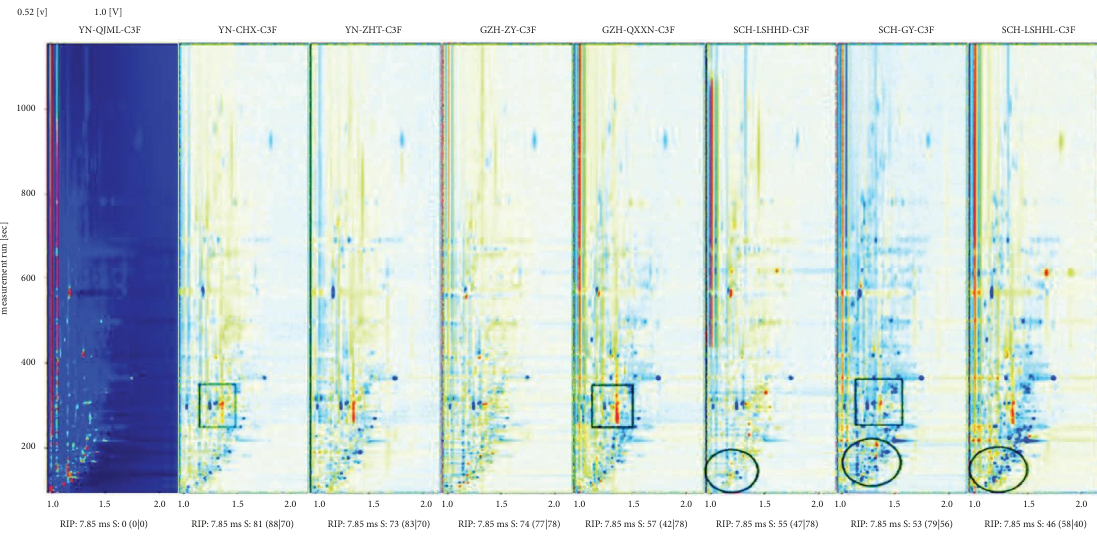
Figure 1: Te ion mobility spectrogram of the eight tobacco samples. Te red area represents a high concentration of aroma compound; the deeper the color, the higher concentration it had, and the blue area was the